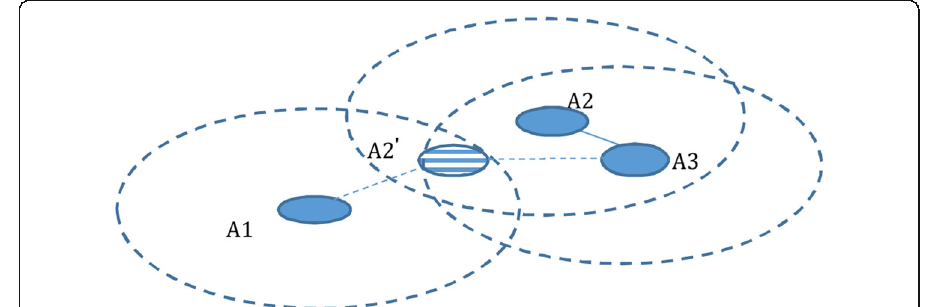
Fig. 2 Best position for moved sponsor node